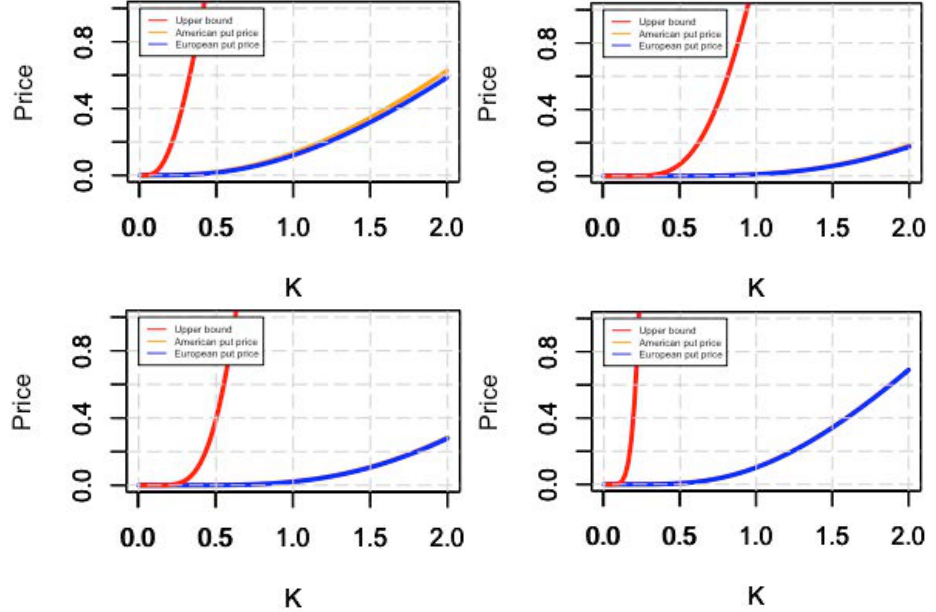
Figure 3. Put option prices written on FNMA during COVID-19. The figure shows the price of American options (yellow lines), European options (blue lines), and bounds for optima exercise of American options (red lines). July 2019, February, March and April